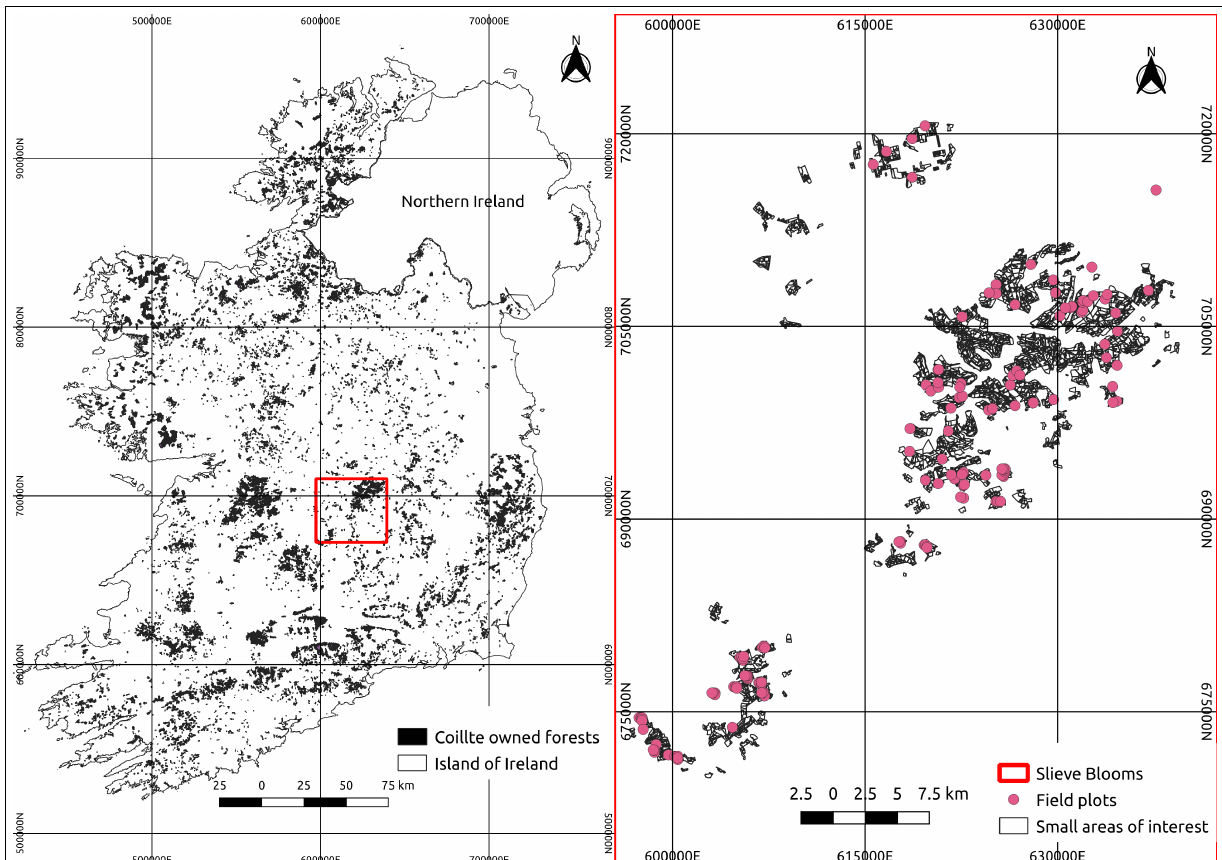
Figure 1. Slieve blooms